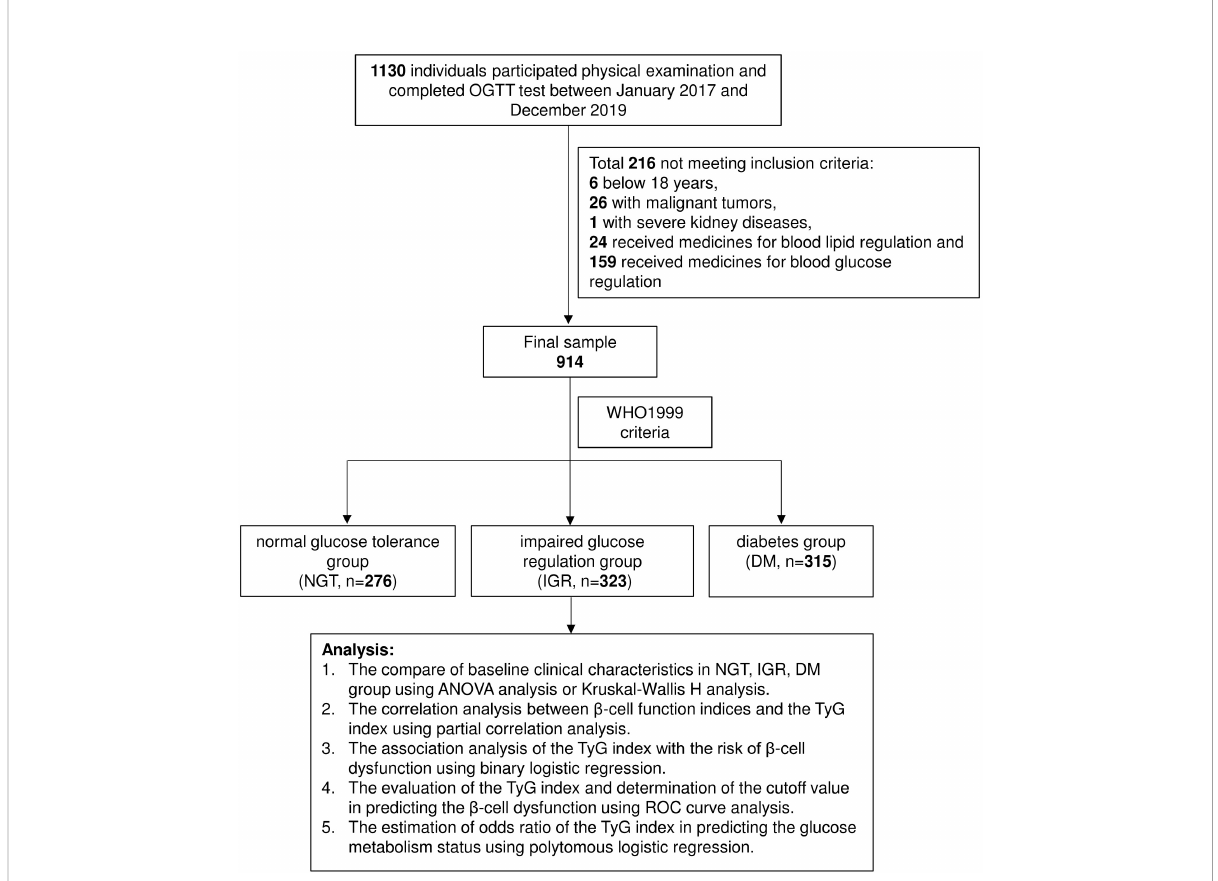
FIGURE 1 Flow chart of the study design. A total of 1130 individuals were recruited for this study at the beginning. Among them, 216 individuals that not match the criteria were excluded. And the left participants were divided into 3 subgroups (NGT: n=268, IGT: n=352, DM: n=314) by the WHO 1999 diagnostic